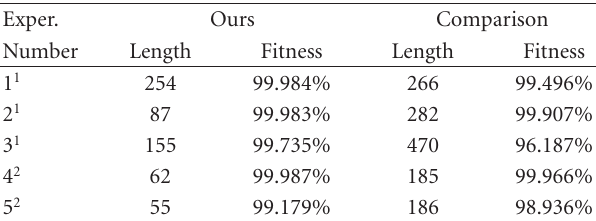
Table 2: Summary of symbolic regression experimental results. Exper. Ours